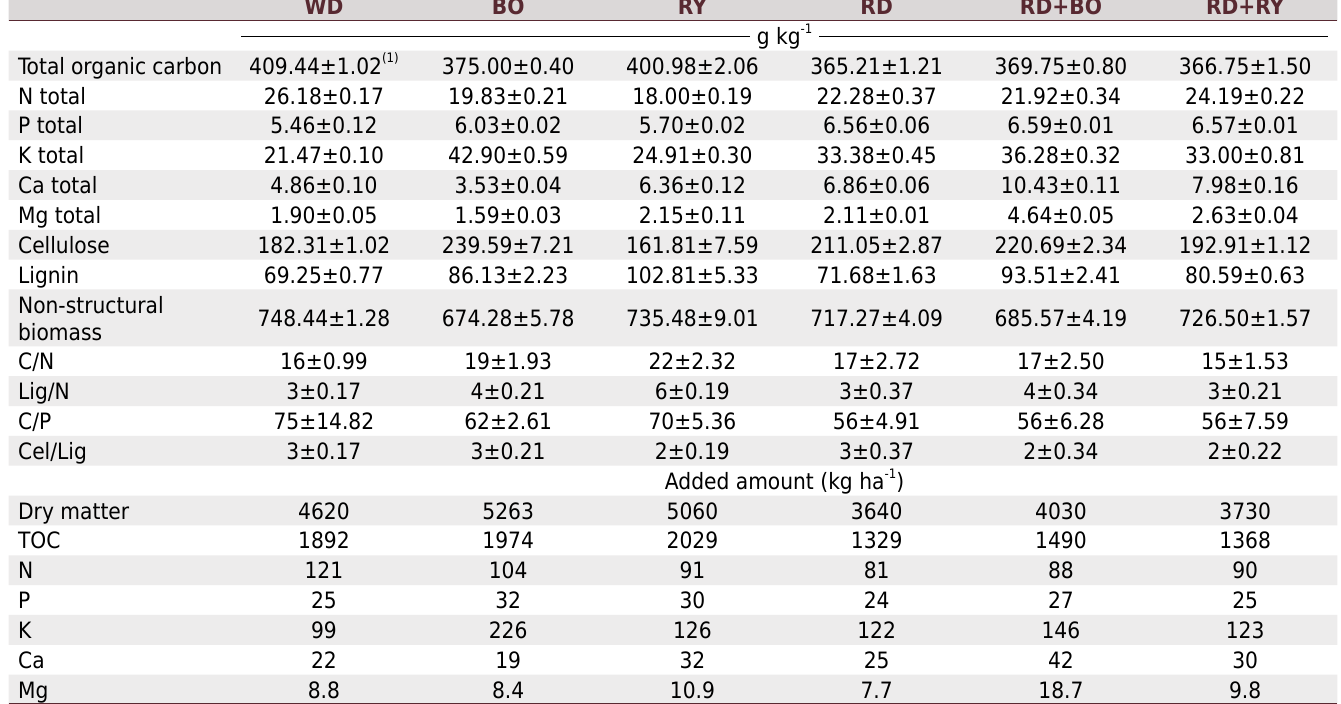
Table 1. Chemical characterization of weeds (WD), black oat (BO), rye (RY), oilseed radish (RD), oilseed radish + black oat (RD + BO), and oilseed radish + rye (RD + RY) residues at the onset of the experiment, and amount of dry matter and nutrients added as soil